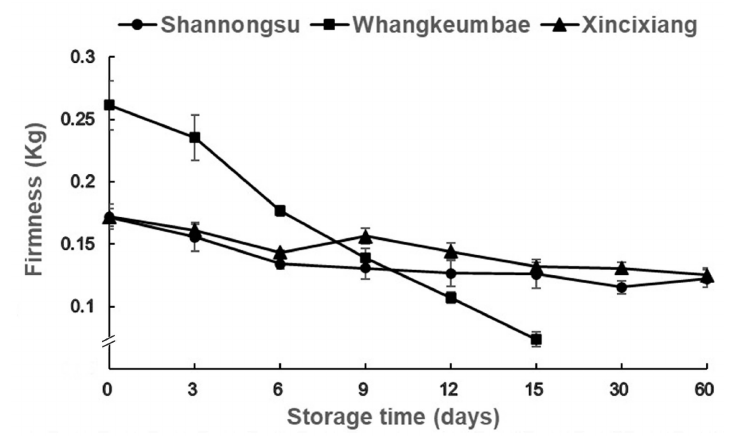
Figure 1. Changes in fruit firmness of three pear cultivars stored at room temperature. Values shown represent means ± SD (n = 3).